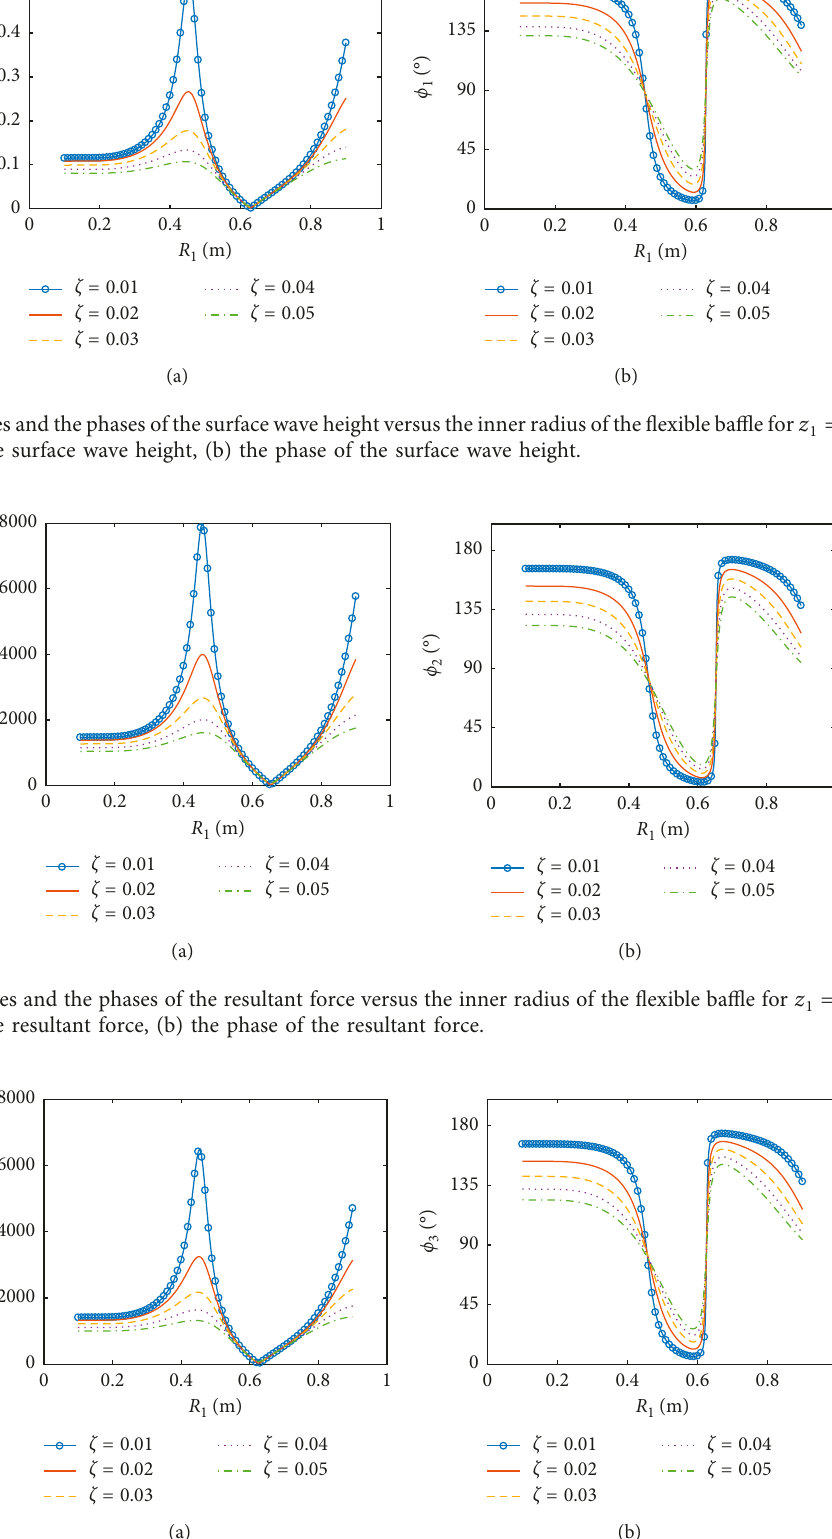
� 0 . 7m and τ � 2mm. 1